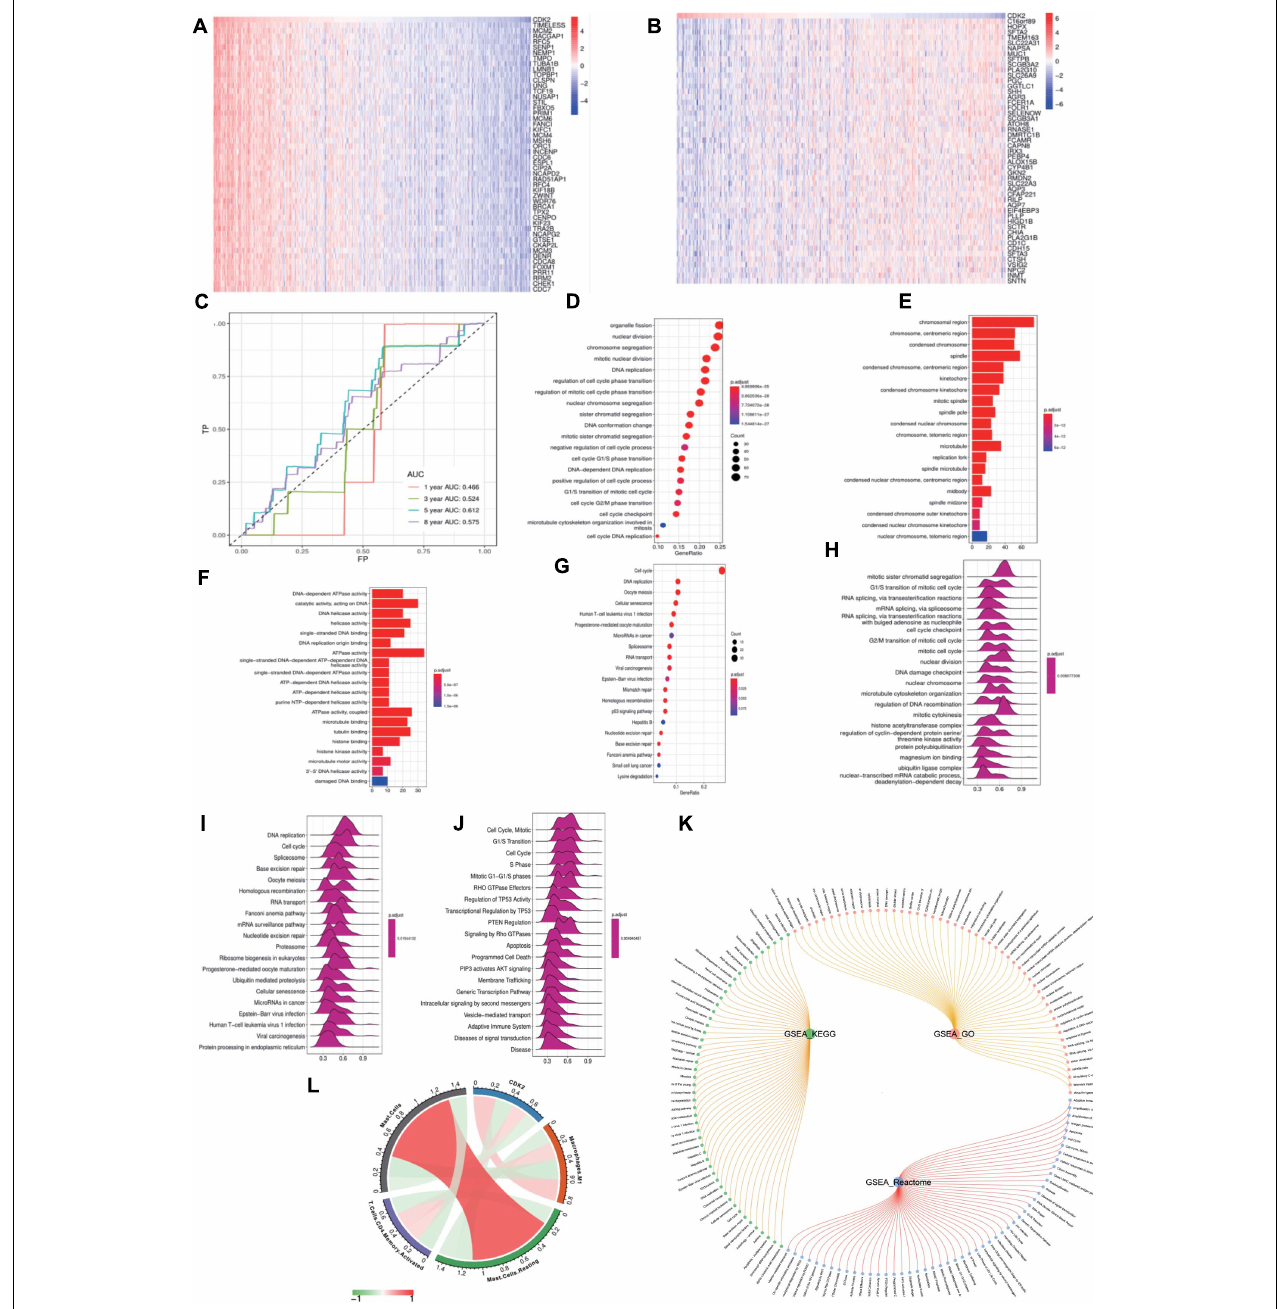
FIGURE 8 | Functional enrichment analysis of CDK2. (A,B) The top 50 heat maps of CDK2 positive and negative genes were shown. (C) The AUC curve of 1, 3, 5, and 8 years to forecast the survival of patients. (D–G) CDK2 was related to the DNA replication, regulation of cell cycle, cell cycle checkpoint, P53 signaling pathway. (H–J) Wave charts about GO, KEGG, Reactome showed that CDK2 involved in classic tumor signaling pathways, such as regulation of TP53 activity, PTEN regulation, apoptosis, P13K-AKT signaling pathway. (K) The circle graph of pathways. (L) CDK2 was positively correlated with CD4 T cells (Cor = 0.1679, P = 0.0003), macrophage M1 (Cor = 0.2437, P = 1.40E-07) and negatively correlated with Mast cells (Cor = –0.1545, P = 0.0009) by CIBERSOPT algorithm.